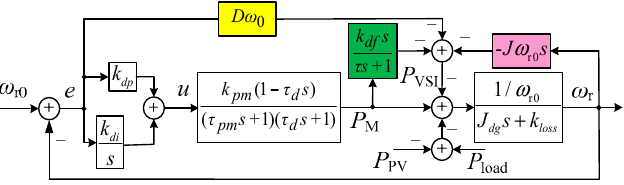
Figure 10. Proposed control strategy for the DGS to support dynamic frequency control.